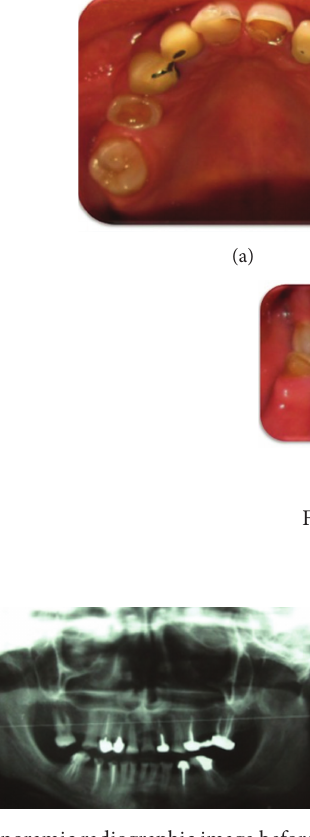
Figure 2: Panoramic radiographic image before